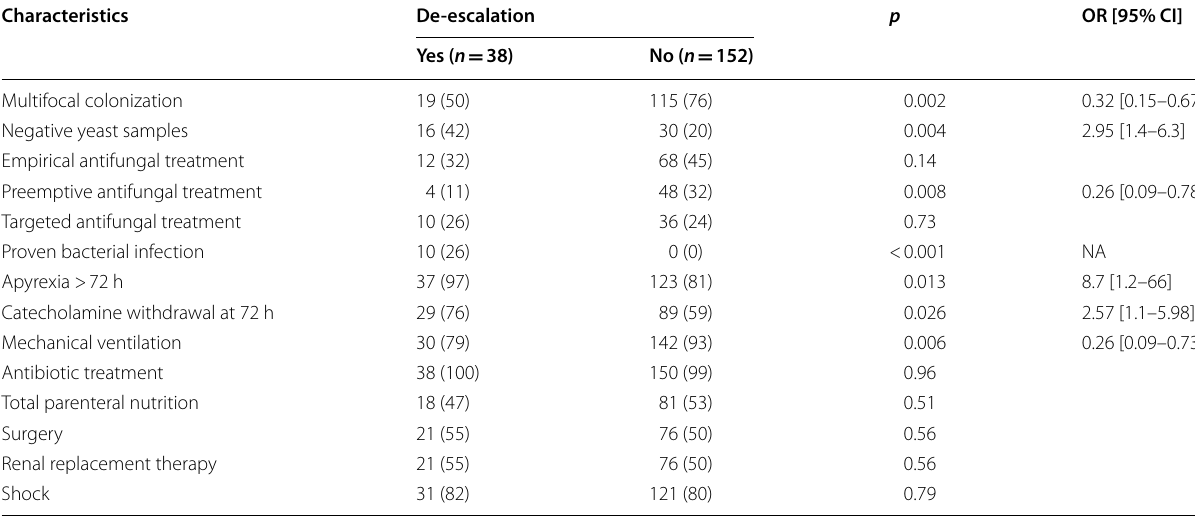
Table 2 Patient characteristics during ICU stay